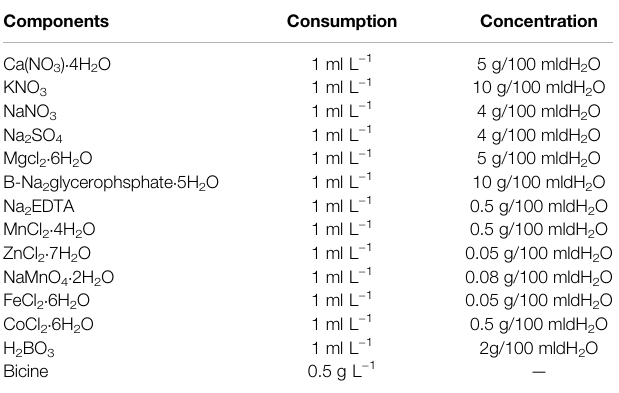
TABLE 1 | Formulation of MA. Components Consumption Concentration